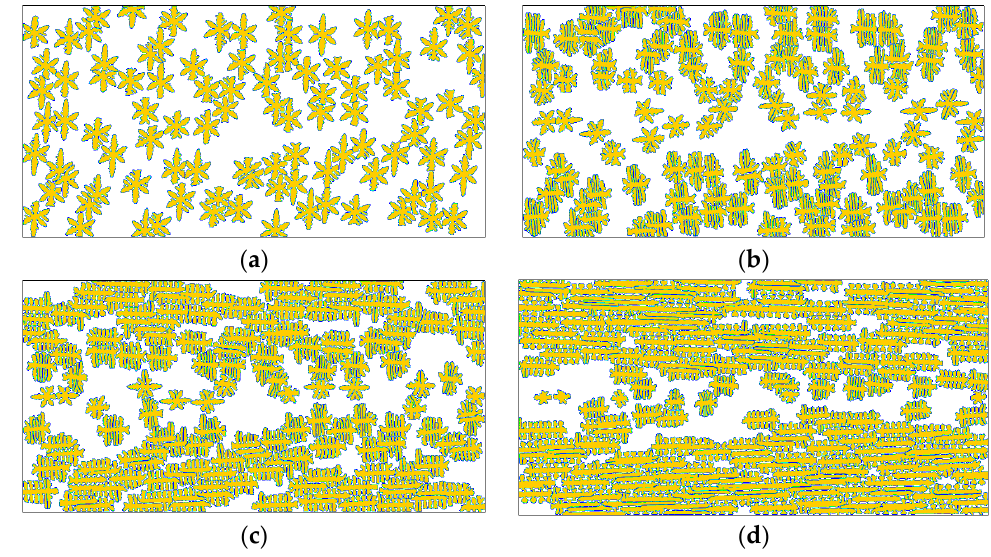
Figure 8. Simulated crystallization morphologies in the crystal order parameter field for different flow strength at anisotropy strength ε = 0.001: ( a ) ˆ γ “ 1.0, t “ 2000; ( b ) ˆ γ “ 10, t “ 1600; ( c ) ˆ γ “ 30, t “ 1400; ( d ) ˆ γ “ 100, t “ 1000. Here the time instants are chosen to ensure the results show similar sizes of crystallized regions.